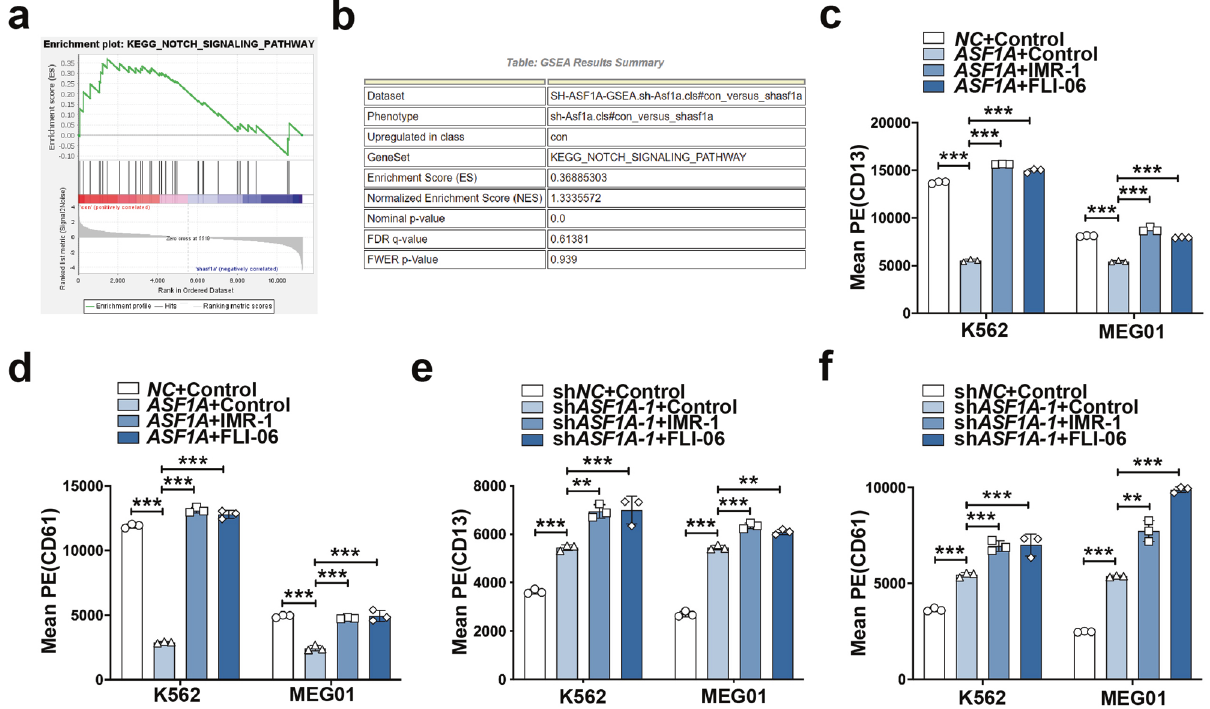
Fig. 3 ASF1A enhanced CML transformation via Notch signaling. a , b Gene-set-enrichment analysis was performed using transcriptomes of K562 cells expressing empty vector (sh NC ) vs sh ASF1A-1 ( a ). The speci fi c properties of the plot in b . c , d FACS analysis of CD13 and CD61 levels in K562 and MEG01 cells expressing either empty vector ( NC ) or ASF1A , treated with control, IMR-1 (20 μ M) or FLI-06 (5 μ M) for 48 h. e , f FACS analysis of CD13 and CD61 levels in K562 and MEG01 cells expressing either empty vector (sh NC ) or sh ASF1A-1 , treated with control, IMR-1 (20 μ M) or FLI-06 (5 μ M) for 48 h. Statistical signi fi cance was determined by One-way ANOVA. Data are shown as mean ± standard deviation (SD). Data are shown as a representative result with three repeats from three independent experiments. The cell lines are applied with three independent lentiviral infections and then treated with the compounds in c – f . ** P < 0.01, *** P <